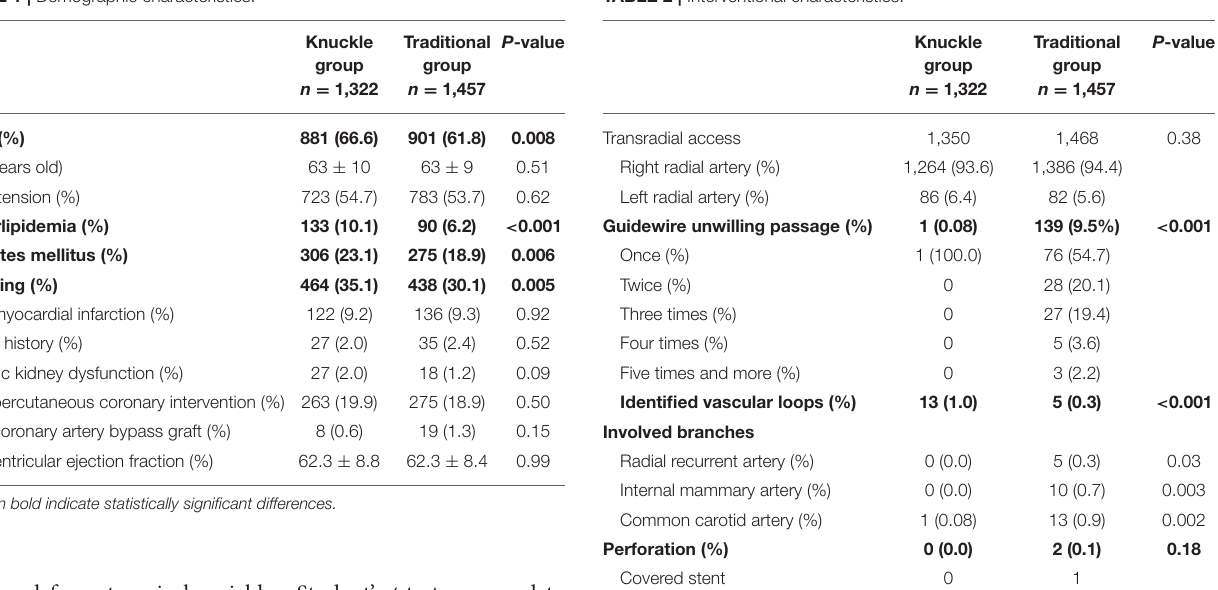
TABLE 1 | Demographic